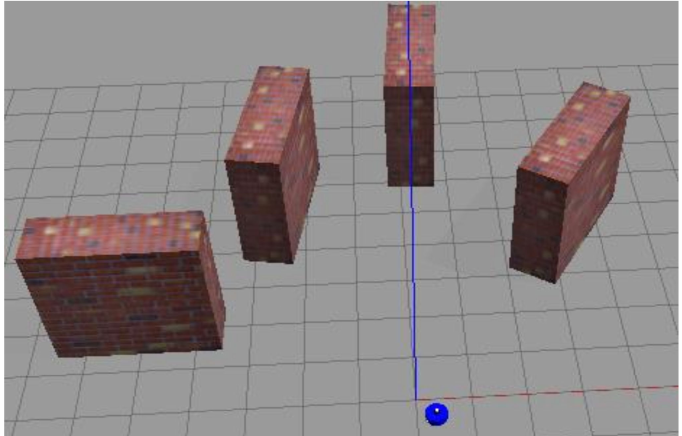
Figure 7. Three-dimensional simulation environment and mobile robot. Red rectangular blocks represent obstacles, and blue cylinder represents mobile